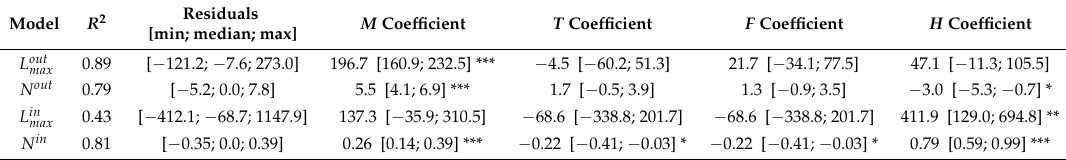
Table 3. Linear model results and significance of the regression coefficients 1 . [95% conf. interval].